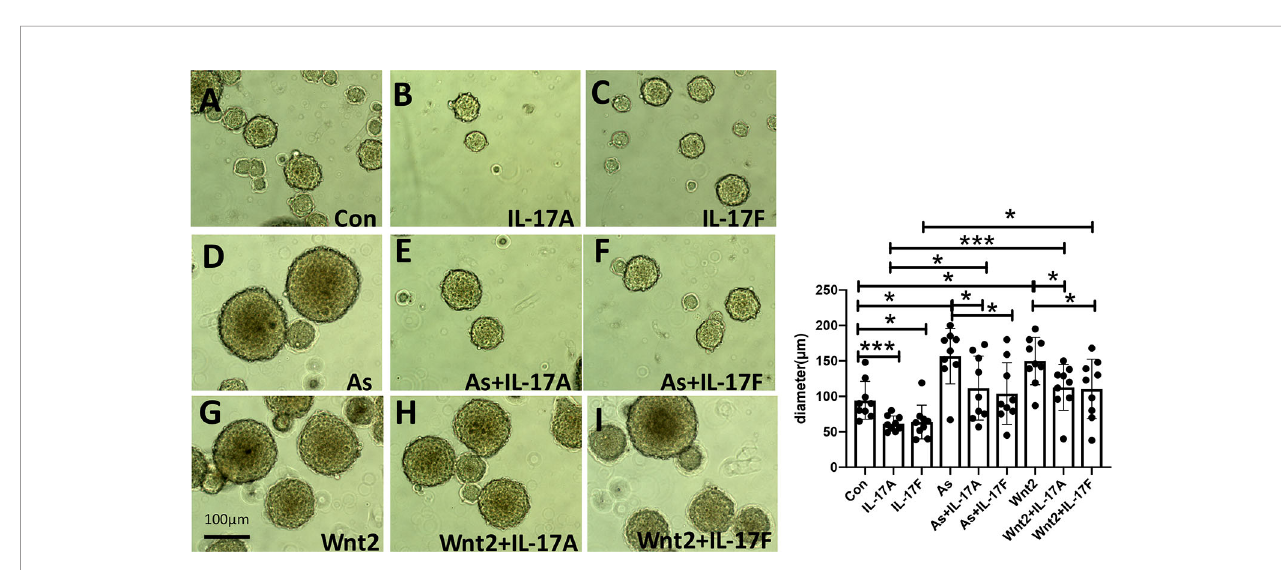
FIGURE 7 | NSCs ’ growth and proliferation in vitro is activated by administering As IV and Wnt2-expressing virus but inhibited by treatment with IL-17A and IL-17F. (A – C, D, G) Diameters of neurospheres were decreased by administering IL-17A and IL-17F, while increased by administering As IV or the Wnt2-expressing virus. (B, C, E, F, H, I) The downregulation on NSCs by IL-17A and IL-17F could be reversed by treatment with As IV and the Wnt2-expressing virus. n = 3, *p < 0.05, ***p < 0.001. Con, control; IL, interleukin; As, Astragaloside IV; NSCs, neural stem